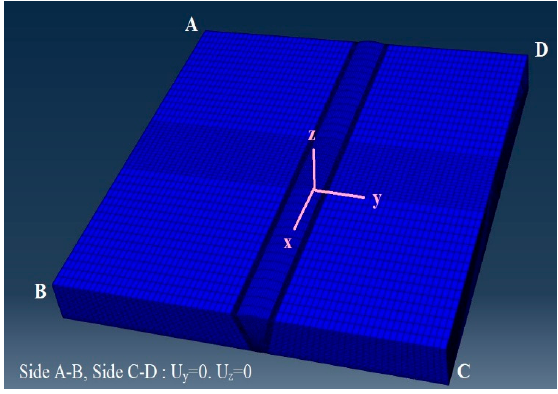
Figure 2. Finite element mesh of 3-D model.